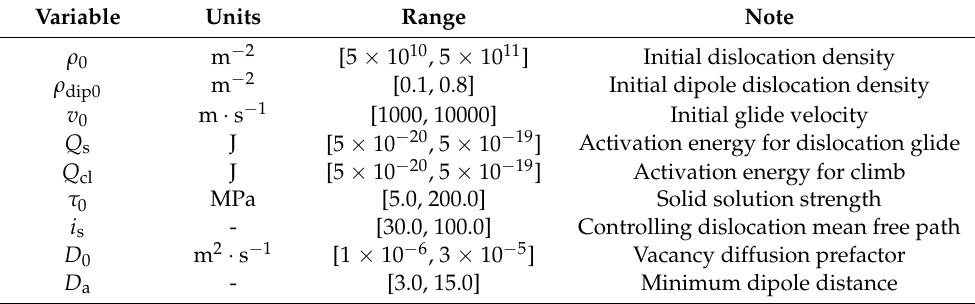
Table 6. Ranges of the adjustable parameters for the dislocation-density-based CP model.